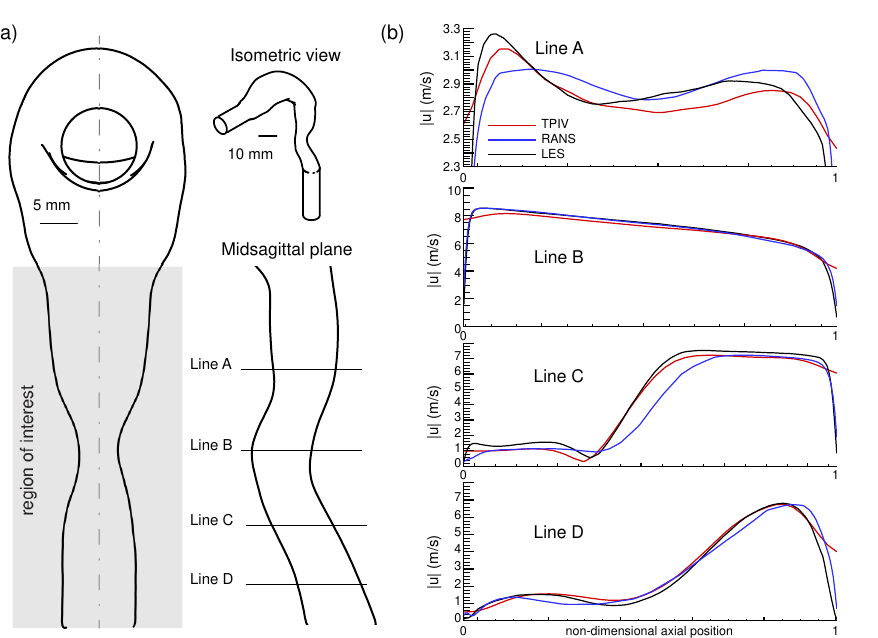
Fig 6. 1-dimensional velocity magnitude curves for Re = 7’000 case. (a): Schematic of the full mouth-throat model geometry (see isometric view) used in the fabrication of the experimental phantom and computational mesh. The area illuminated via laser (Region of Interest) and imaged using tomographic particle image velocimetry (TPIV) is noted, along with four lines (labeled A-D) spanning the mid-sagittal plane. (b) Comparison of 1D velocity profiles along the anotated Lines